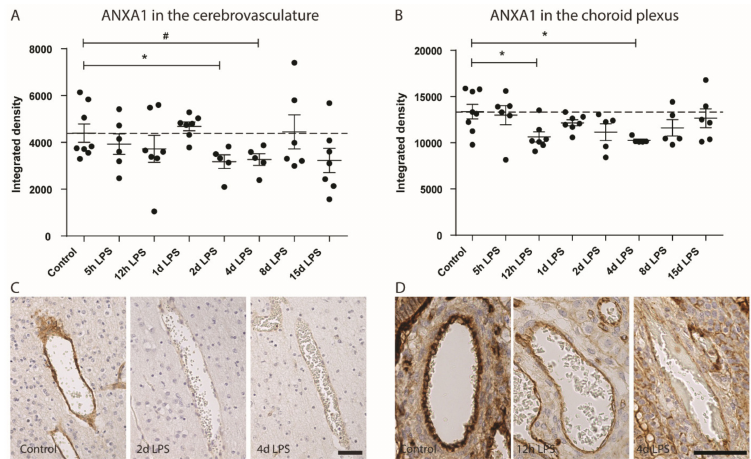
Figure 1. Annexin A1 (ANXA1) expression over time in response to intra-amniotic lipopolysaccharide (LPS) exposure in the vasculature of the fetal brain parenchyma and the choroid plexus. ( A ) Integrated density (mean grey value of stained area*percentage of the stained area) of ANXA1 immunoreactivity in the cerebrovasculature. ( B ) The integrated density of ANXA1 expression within the vasculature of the choroid plexus. ( C ) Representative picture of ANXA1 expression within the blood vessels within the brain parenchyma of coronal sections containing the hippocampus; 200 × magnification, scale bar 50 µ m. ( D ) Representative picture of ANXA1 within the blood vessels of the choroid plexus; 400 × magnification, scale bar 50 µ m. Data are presented as mean / standard error of the mean and the Kruskal–Wallis test was performed: p < 0.05 = *, p < 0.1 =